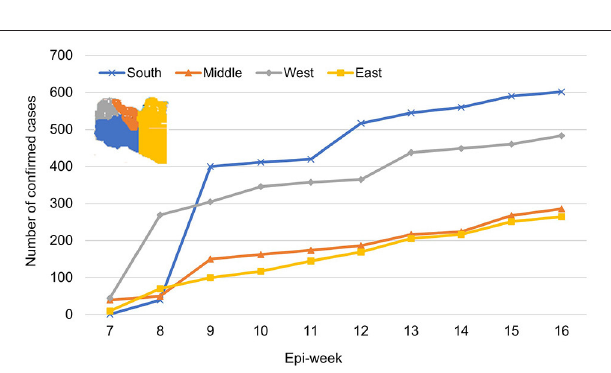
FIGURE 4 | The prevalence of COVID-19 infections among the Libyan population in the four geographic regions over 16 epi-weeks (April 03–July 31,